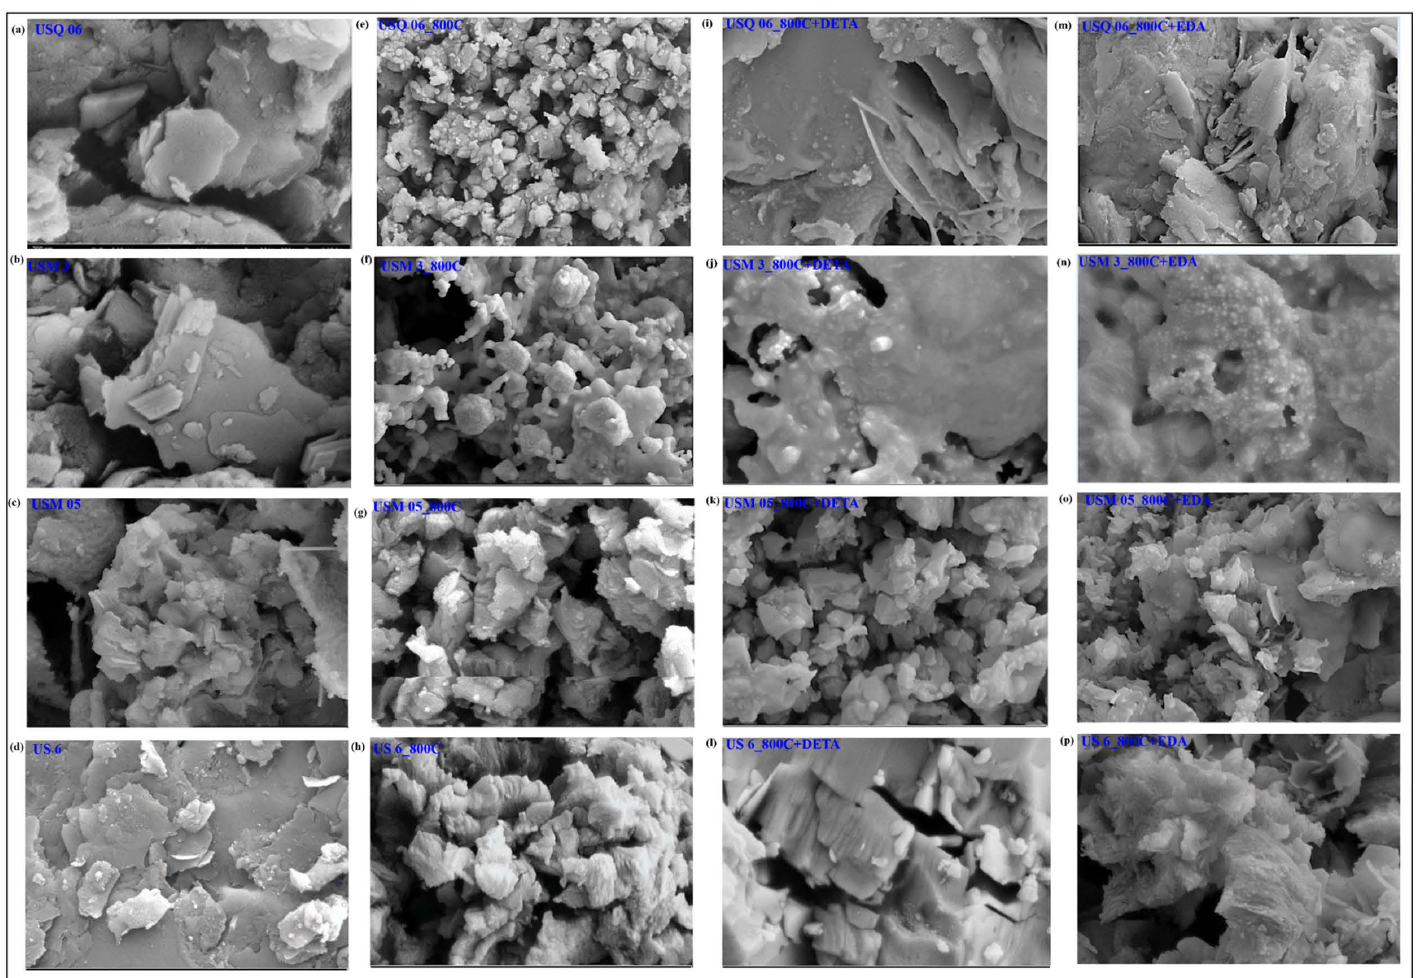
Figure 4. Changes in microfabric of shale after treatments. Raw shale ( a – d ), Spent shale ( e – h ), DETA-modified spent shale ( i – l ), and EDA-modified spent shale ( m – p ) at 200 nm resolution and 30 kx